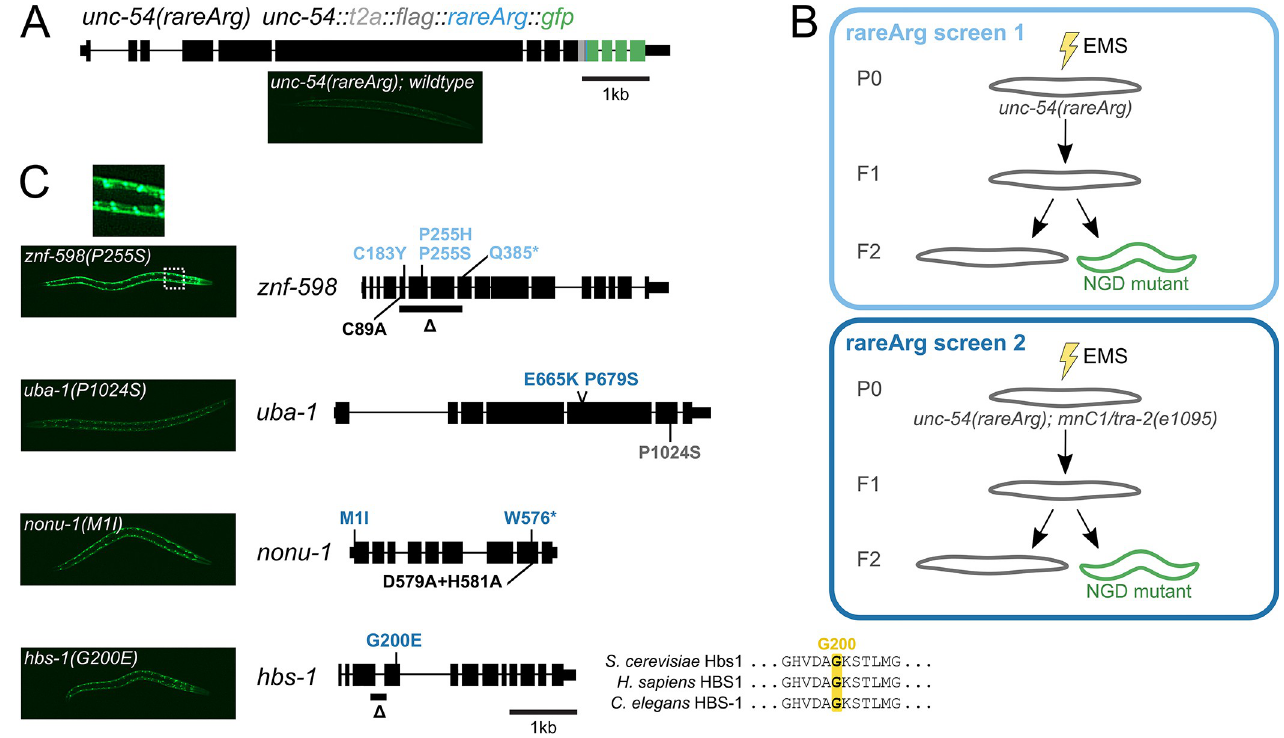
Fig 1. Genetic screens identify suppressors of No-Go mRNA Decay. (A) Gene diagram showing annotated exons (black rectangles) of unc-54(rareArg) . Colored rectangles represent CRISPR/Cas9 insertions at the endogenous unc-54 locus: T2A sequence (gray), FLAG (dark gray), 12 rare arginine codons (blue), and GFP (green). (B) Schematics of rareArg genetic screens. (C) znf-598 , uba-1 , nonu-1 , and hbs-1 alleles with representative image of one allele per gene on the left. Black rectangles represent exons, thicker rectangles are CDS, and thin lines are introns. Mutations made via EMS in the rareArg screen 1 (light blue) or rareArg screen 2 (dark blue), and via CRISPR/Cas9 (black) or CGC (gray) are shown. For HBS-1, multiple sequence alignment shows conserved glycine (G200) in GTPase domain.